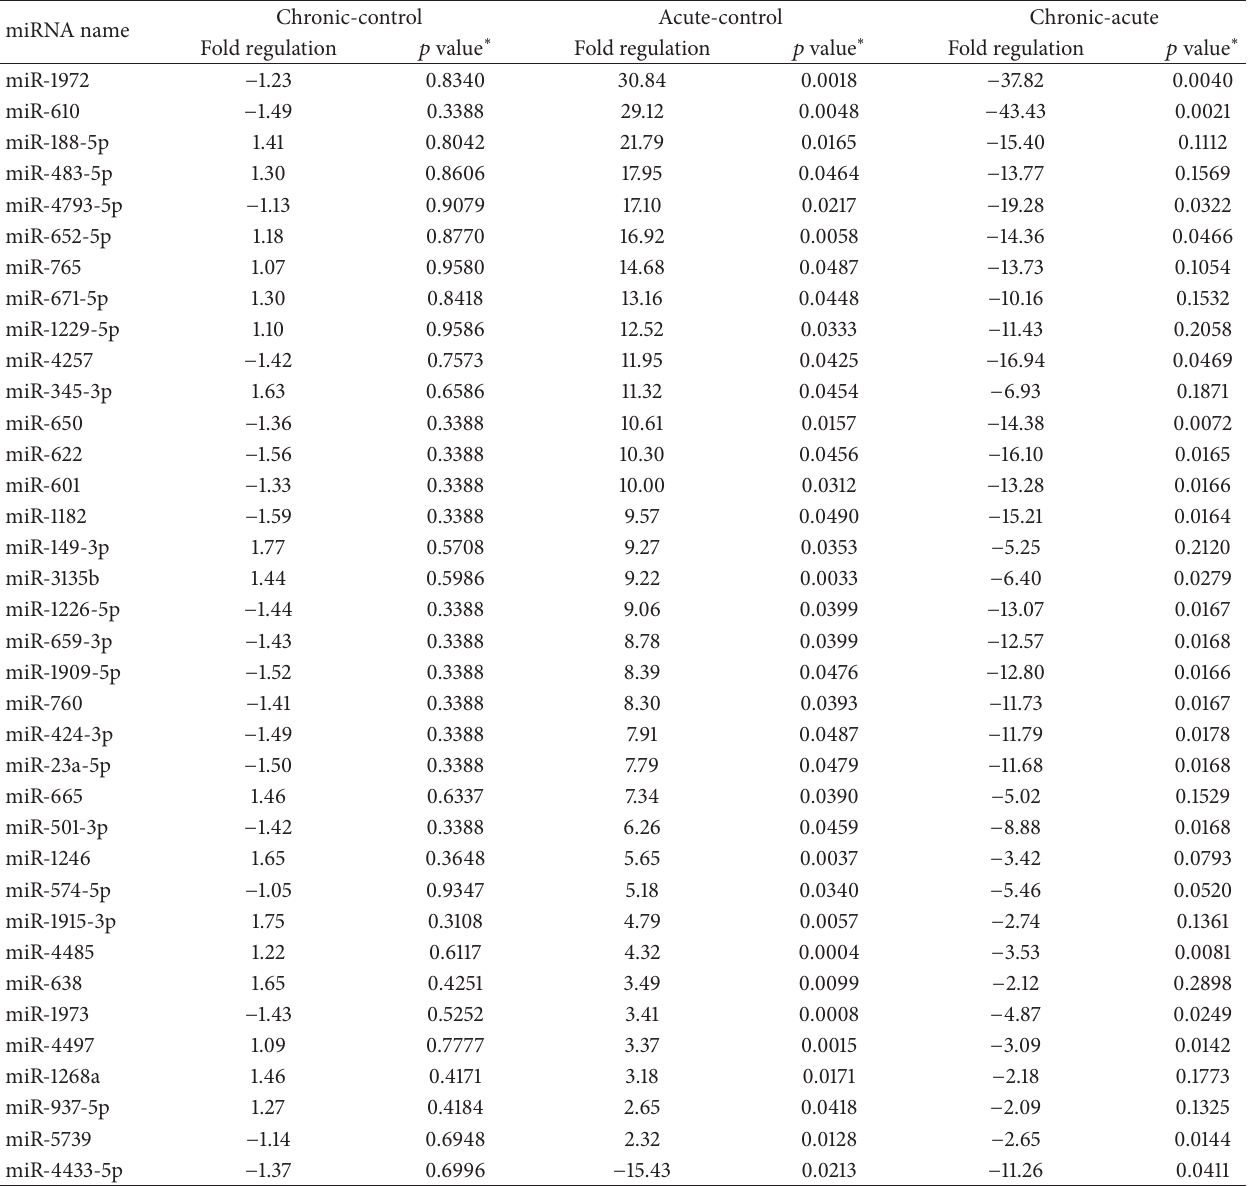
Table 4: List of significantly altered miRNA expressions in acute